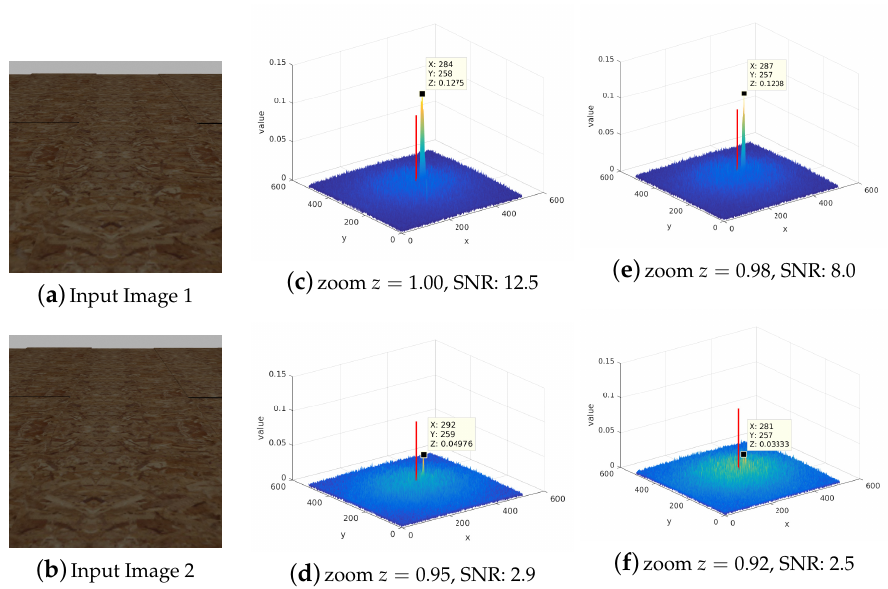
Figure 5. Translation PSDs with different zoom values. The groundtruth zoom between the two input images is 1. To test the influence of zoom on the translation phase shift diagram, we set zoom value from 1.00 to 0.92 manually to re-zoom the second image and then perform phase correlation.